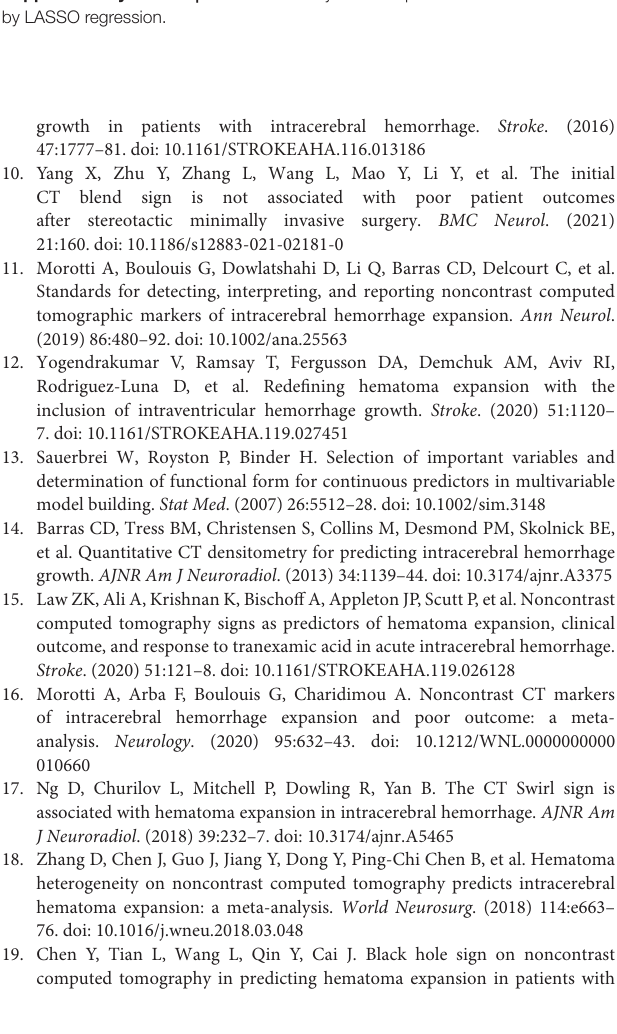
Supplementary Figure 1 | Flowchart for the patient selection of two patient cohorts. Supplementary Figure 2 | Correlation heatmap of the potential predictors (continuous variables) of hematoma expansion (HE). The hemoglobin, hematocrit, and MCHC are the positively related factor of HU, whereas the RDW is the negatively related factor that with statistical significance. SBP, systolic pressure; DBP, diastolic pressure; RBC, red blood cell; Hb, hemoglobin; HCT, hematocrit; MCV, mean corpuscular volume; MCH, mean corpuscular hemoglobin; MCHC, mean corpuscular hemoglobin concentration; RDW, RBC distribution width; PLT, platelet; PDW, platelet distribution width; PT, prothrombin time; APTT, activated partial thromboplastin time; INR, international normalized ratio; TC, total cholesterol; SG, serum glucose; BV, baseline hematoma volume; HU, Hounsfield units. Supplementary Figure 3 | The receiver operating characteristic (ROC) analysis of the multivariate model. The C-index/area under the curve (AUC) is 0.806. The corresponding nomogram score for cutoff is 126 (asterisk). Supplementary Table 1 | Multivariate analysis of the predictors of HE identified by LASSO